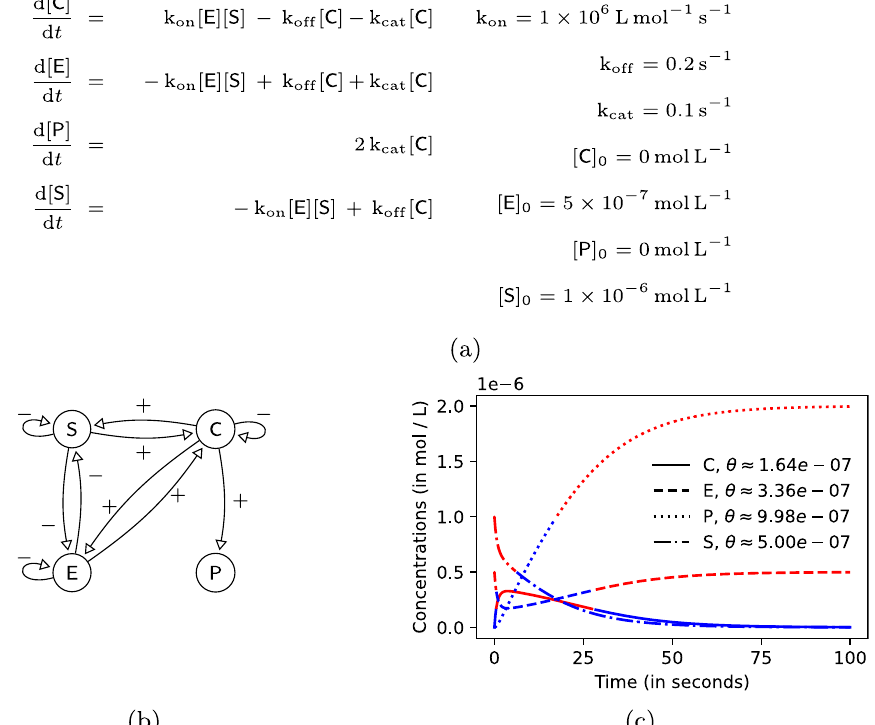
Fig. 2 For the running example depicted in Eq. (1): a ODE system and its parametrisation; b prior knowledge network; c multivariate time series obtained by simulation of the ODE system, midrange‑based binarisation thresholds, and resulting binarisation (blue if 0 and red if